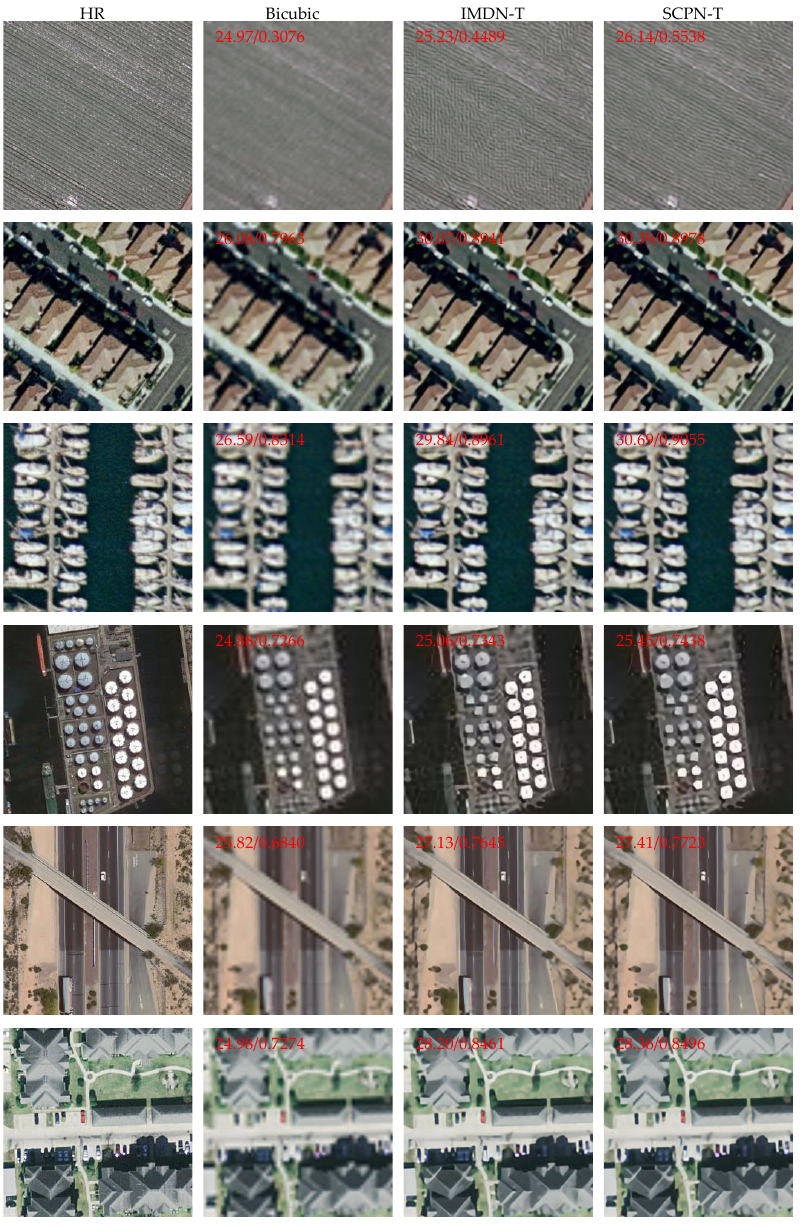
Figure 10. Visual results for remote-sensing images. The numbers in the upper left corner of the images denotes the PSNR and SSIM values of themselves.